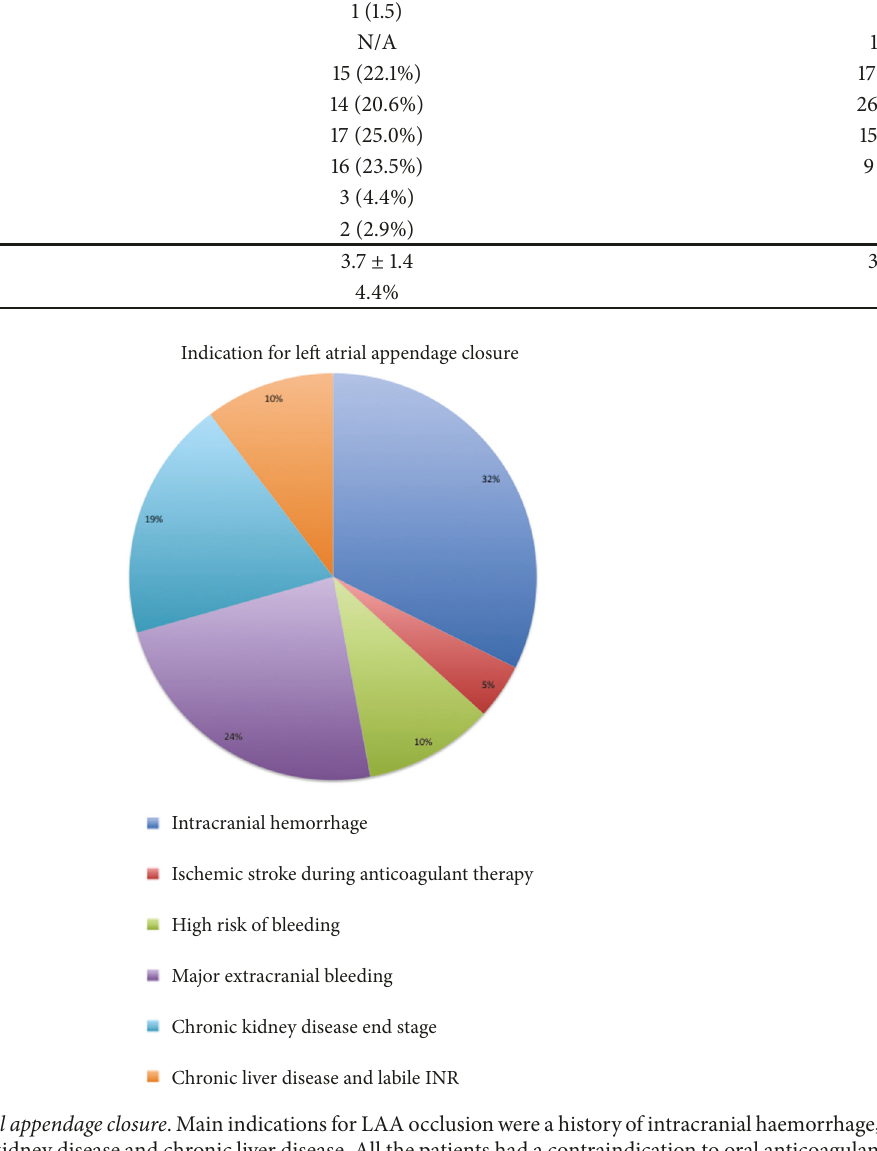
day after the procedure, approximately 24 hours after the first administration of the antiplatelet